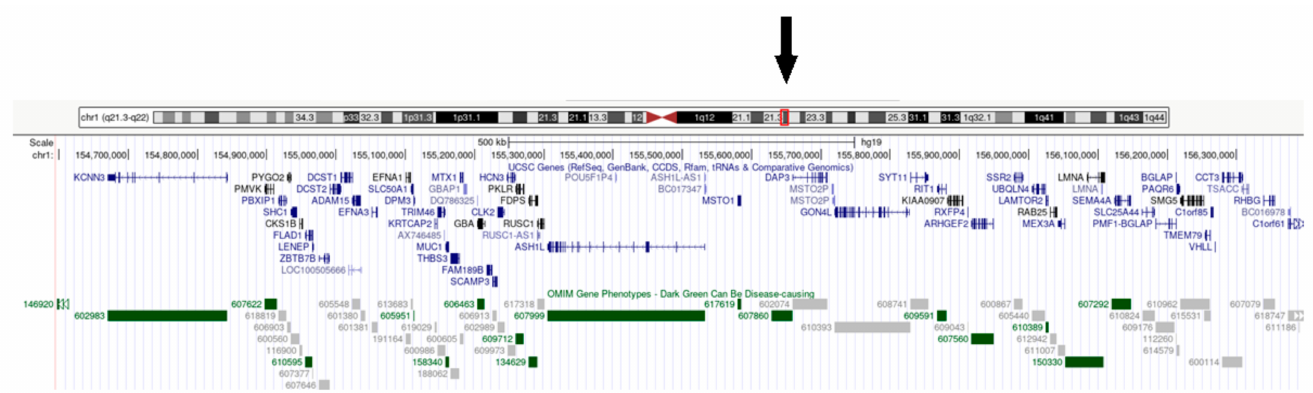
Figure 3. 1q21.3q22 region, duplicated in our patient and its gene content, highlighted by the black